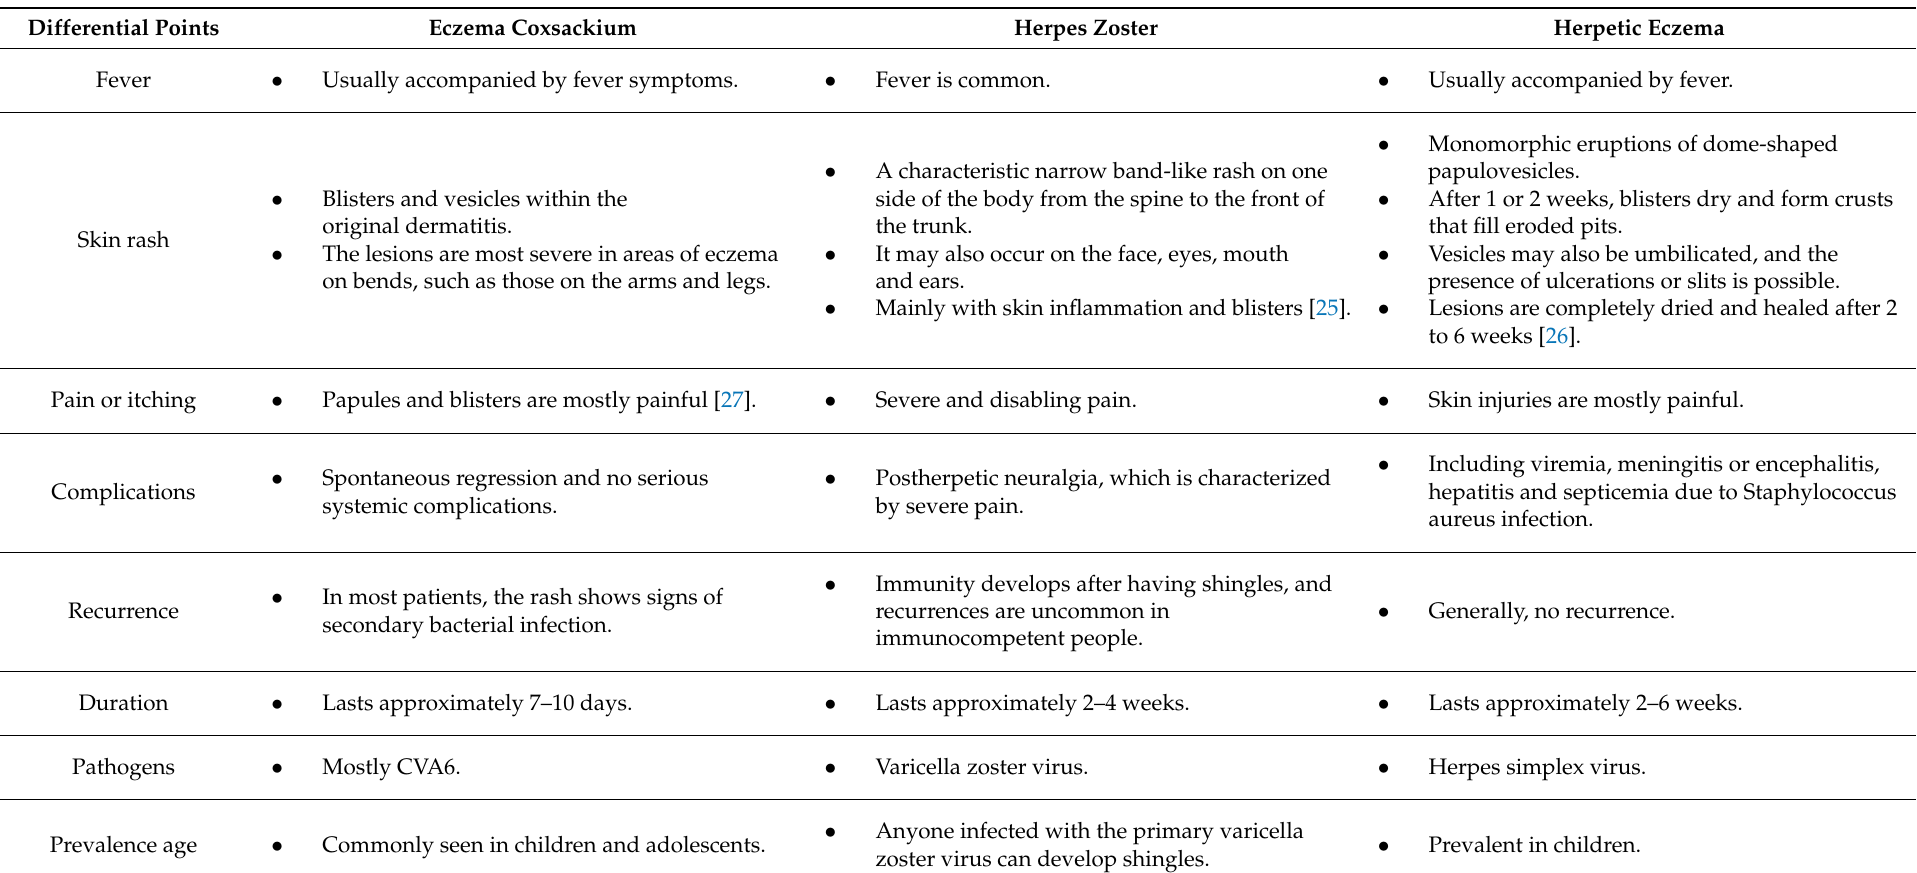
Table 2. Differential diagnosis of eczema